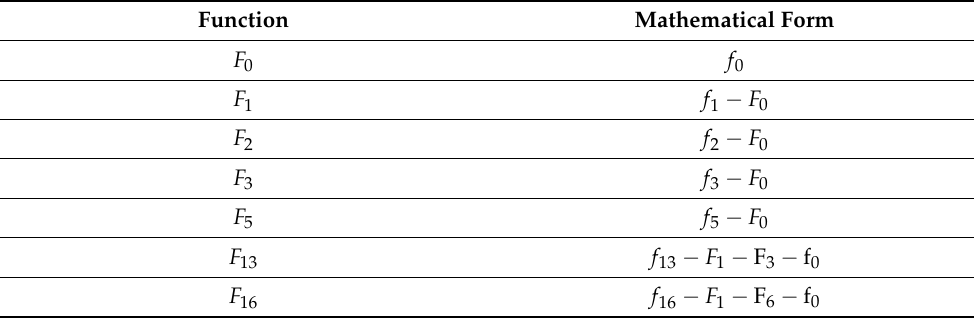
Table 4. The reduced-order functions for estimating SRV using input